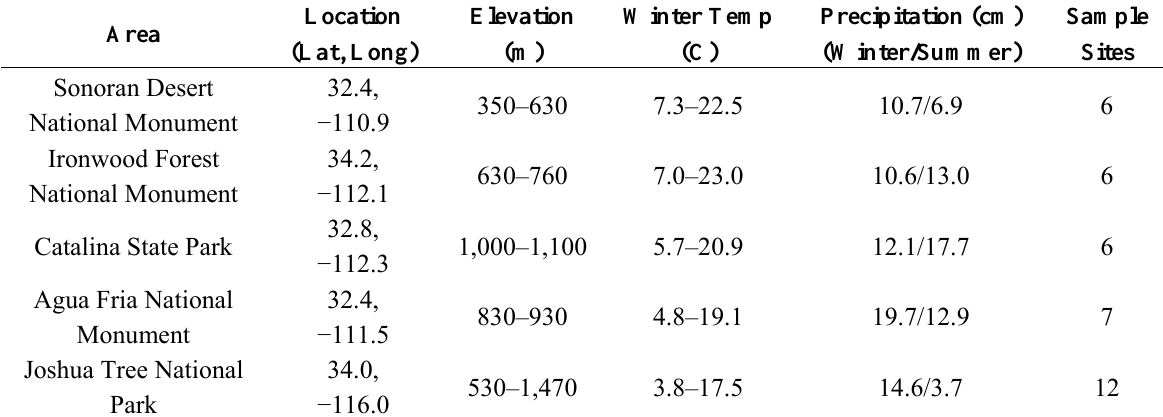
Table 1. Description of the five study areas used in the collection of cover and height estimates for the calibration and evaluation of remotely sensed estimates of winter annual biomass, including the number of sample sites used to estimate winter annual biomass across each of the